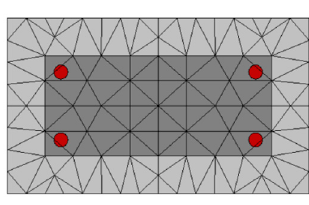
Figure 4. Section discretization.